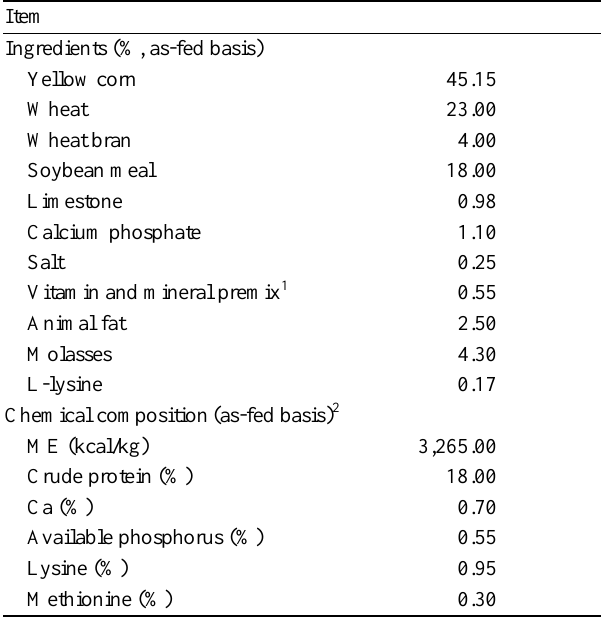
Table 1. Ingredients and chemical compositions of the basal